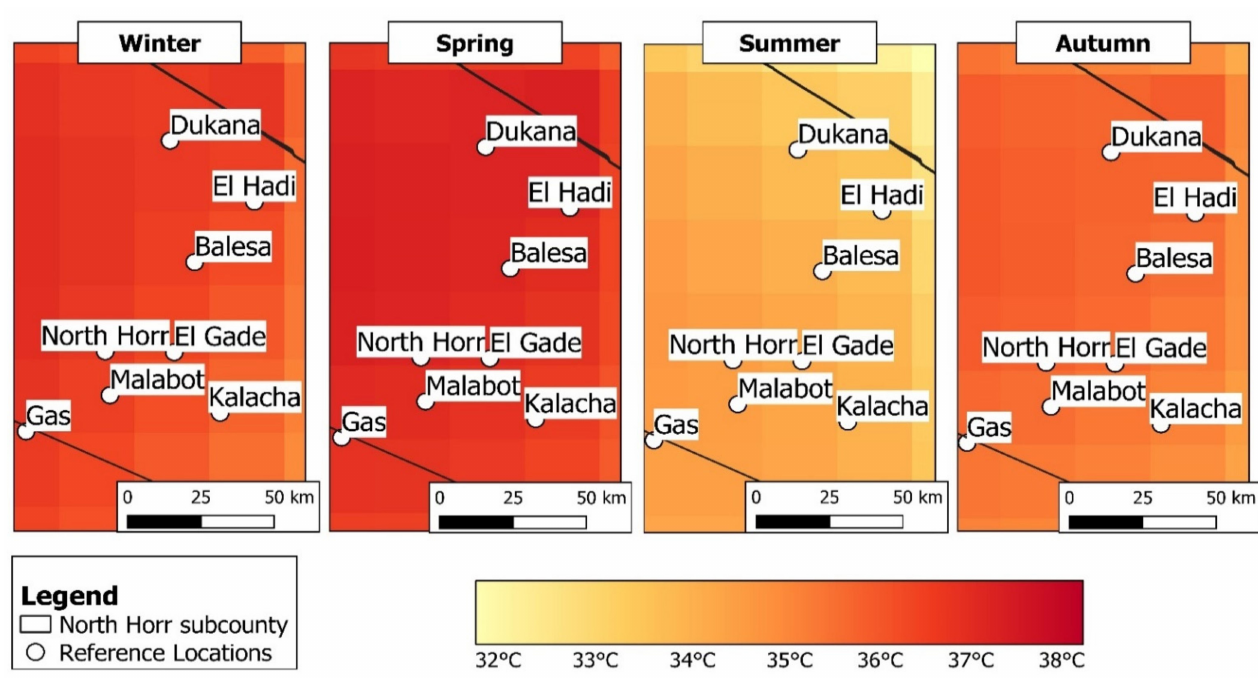
Figure 8. ORH isotherm maps representing seasonal mean T MAX values at the local scale for North Horr Sub-County, for winter (January, February, March), spring (April, May, June), summer (July, August, September) and autumn (October, November, December) seasons. White dots represent the location of the reference points.